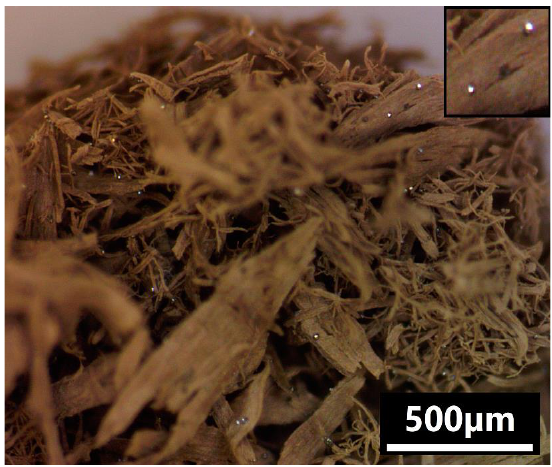
Figure 7. Stereomicroscopic image of the small metallic cobalt particles on the surface of CoO particles (magnification 55×).